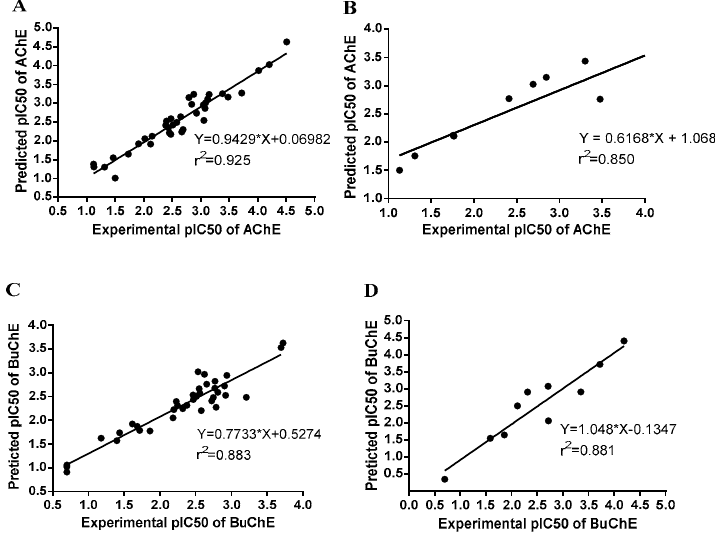
group and minimized the distance of two benzene rings would help obtain high activity, validating that compounds 6-1 and 7-6 could be more effective.